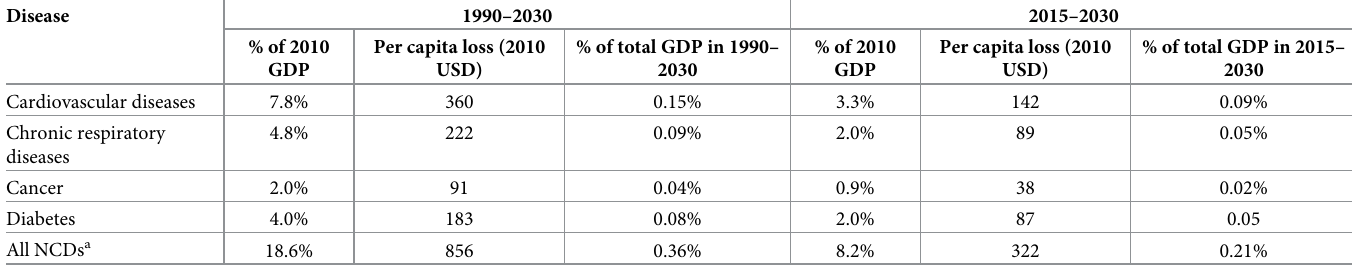
Table 2. Economic burden due to the four NCDs and all NCDs associated with air pollution in China in 1990–2030 and 2015–2030 for different measures of eco- nomic performance. Disease